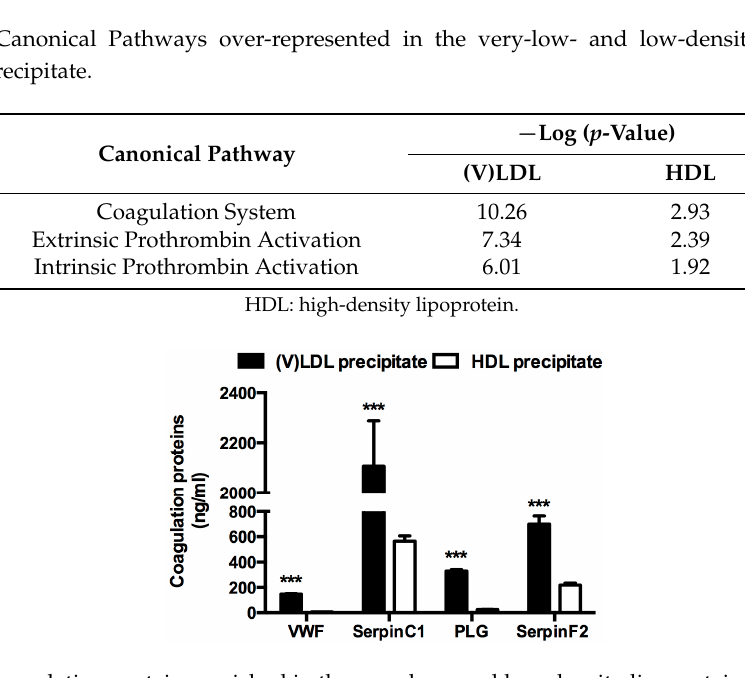
Figure 1. Coagulation proteins enriched in the very-low- and low-density lipoprotein ((V)LDL) and high-density lipoprotein (HDL) precipitates. von Willebrand factor (VWF), SerpinC1, plasminogen (PLG) and SerpinF2 levels in the (V)LDL and HDL precipitates were determined by multiplex immunoassay and normalized to the original volumes of plasma. n = 20, *** p < 0.001 compared to the respective protein levels in the HDL precipitate. Bars represent mean ± standard error of mean (S.E.M).